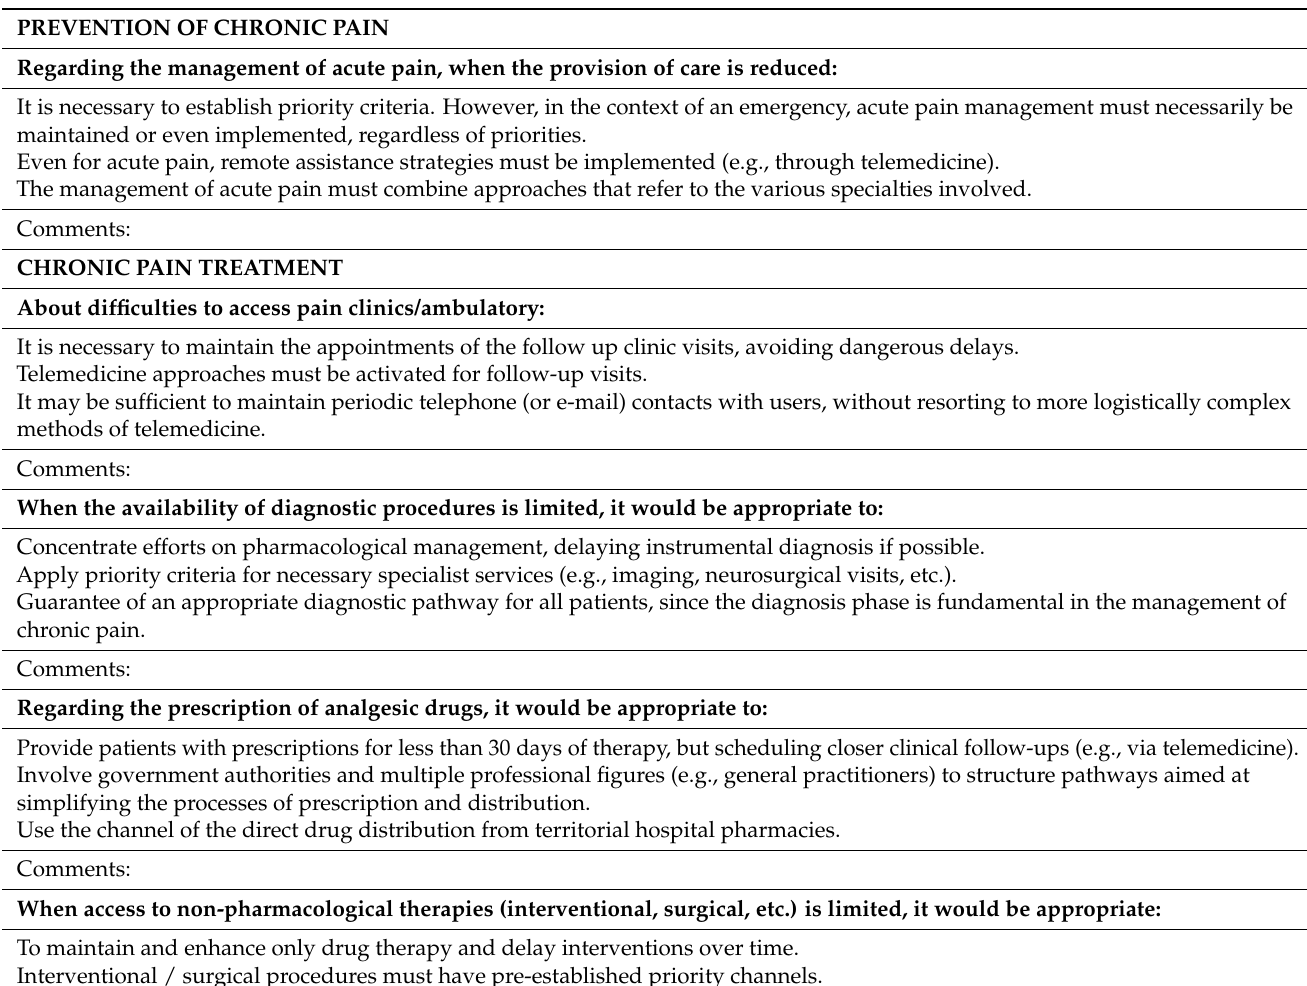
Table 1. First semi-structured